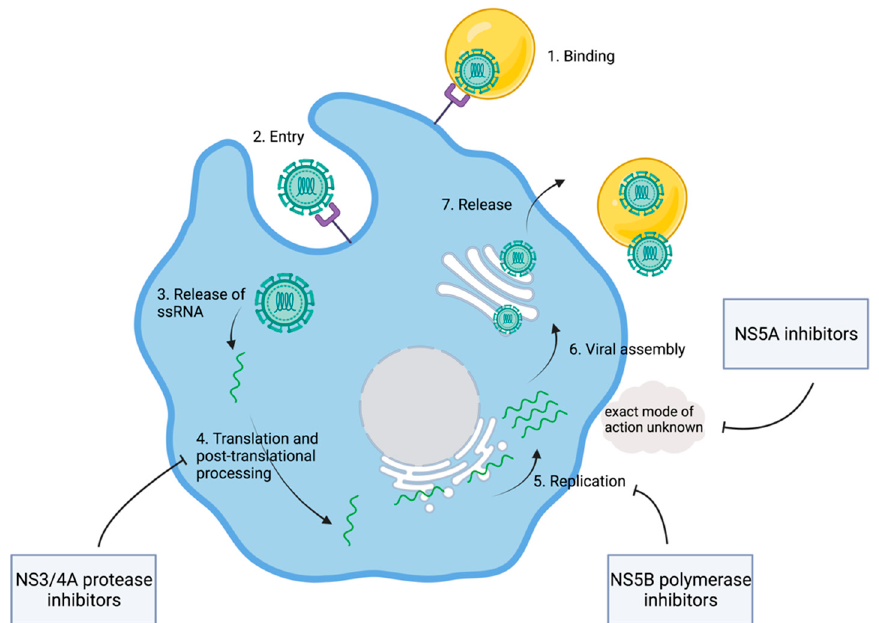
Figure 3. Viral replication and points of attack of direct-acting antiviral agents. Shown are key steps of viral replication and the modes of action of different DAAs. After binding and cellular entry of the viral particle, the ssRNA is released and translated into the HCV polyprotein. DAAs interfere with the viral replication at different stages. NS3/4A protease inhibitors block the processing of the HCV polyprotein. NS5B inhibitors interfere with the viral RNA polymerase. For NS5A inhibitors, an interaction with viral and host proteins is assumed, while the exact mode of action is unknown. Adapted from [44]. Created with BioRender.com.